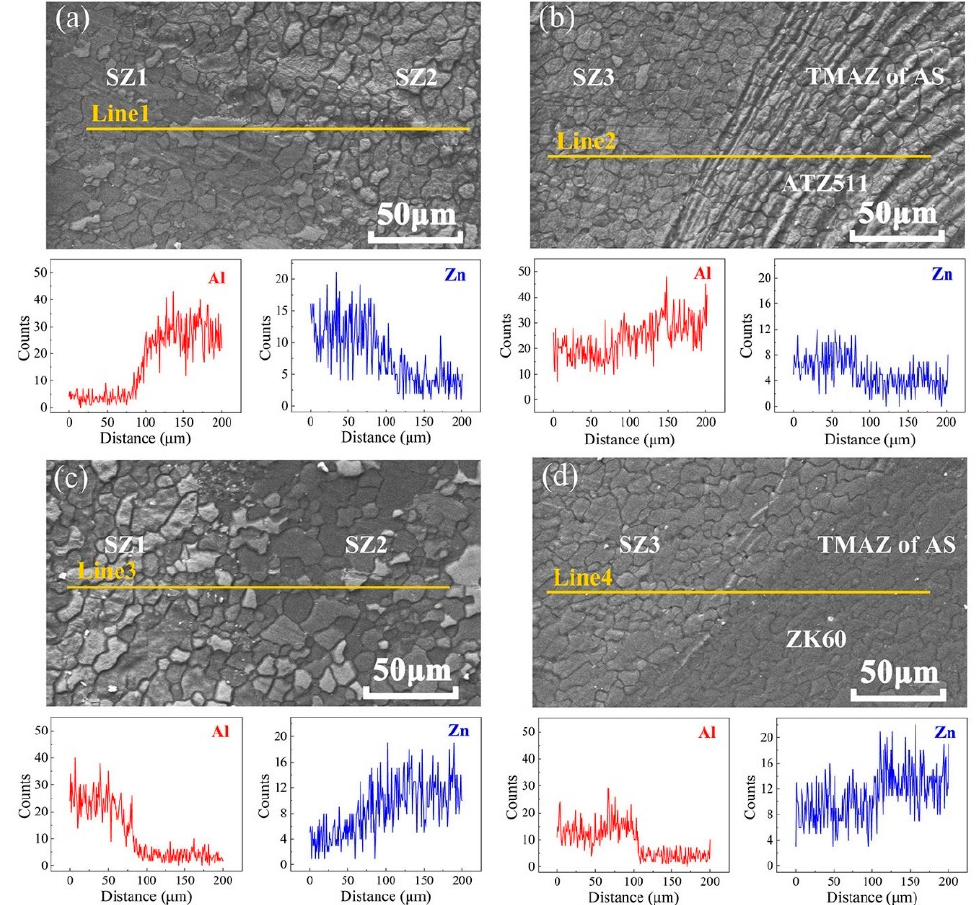
Figure 5. EDS line scanning results: ( a , b ) of the ZK60/ATZ511 joint, ( c , d ) of the ATZ511/ZK60 joint.